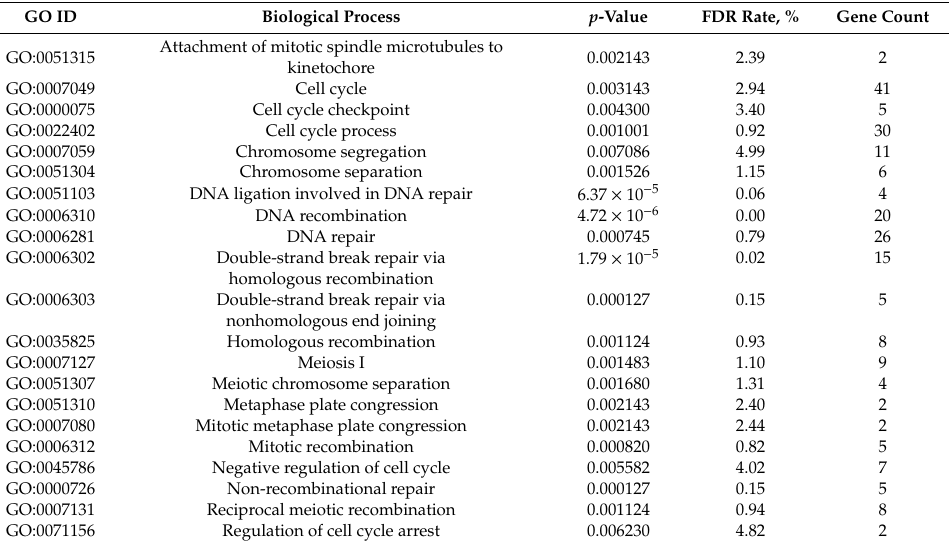
Table 1. Assignment of di ff erentially expressed downregulated genes in knl2 seedlings to di ff erent functional categories related to cell processes. Gene Ontologies were analyzed for term enrichment using the Generic Gene Ontology GO::TermFinder tool (cuto ff of 5% false discovery rate (FDR)).